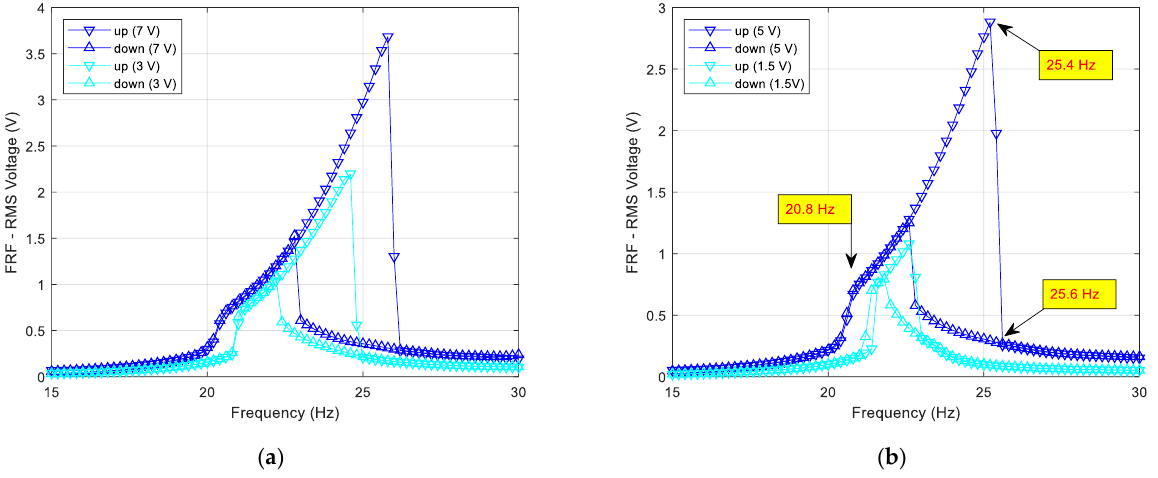
Figure 6. Frequency response function (FRF), obtained by sweeping the frequency up and down with the PEH in open-circuit: ( a ) the amplitudes of the voltages applied to the resonant vibration speaker were 3 V and 7 V; ( b ) the amplitudes of the voltages applied to the resonant vibration speaker were 1.5 V and 5 V.